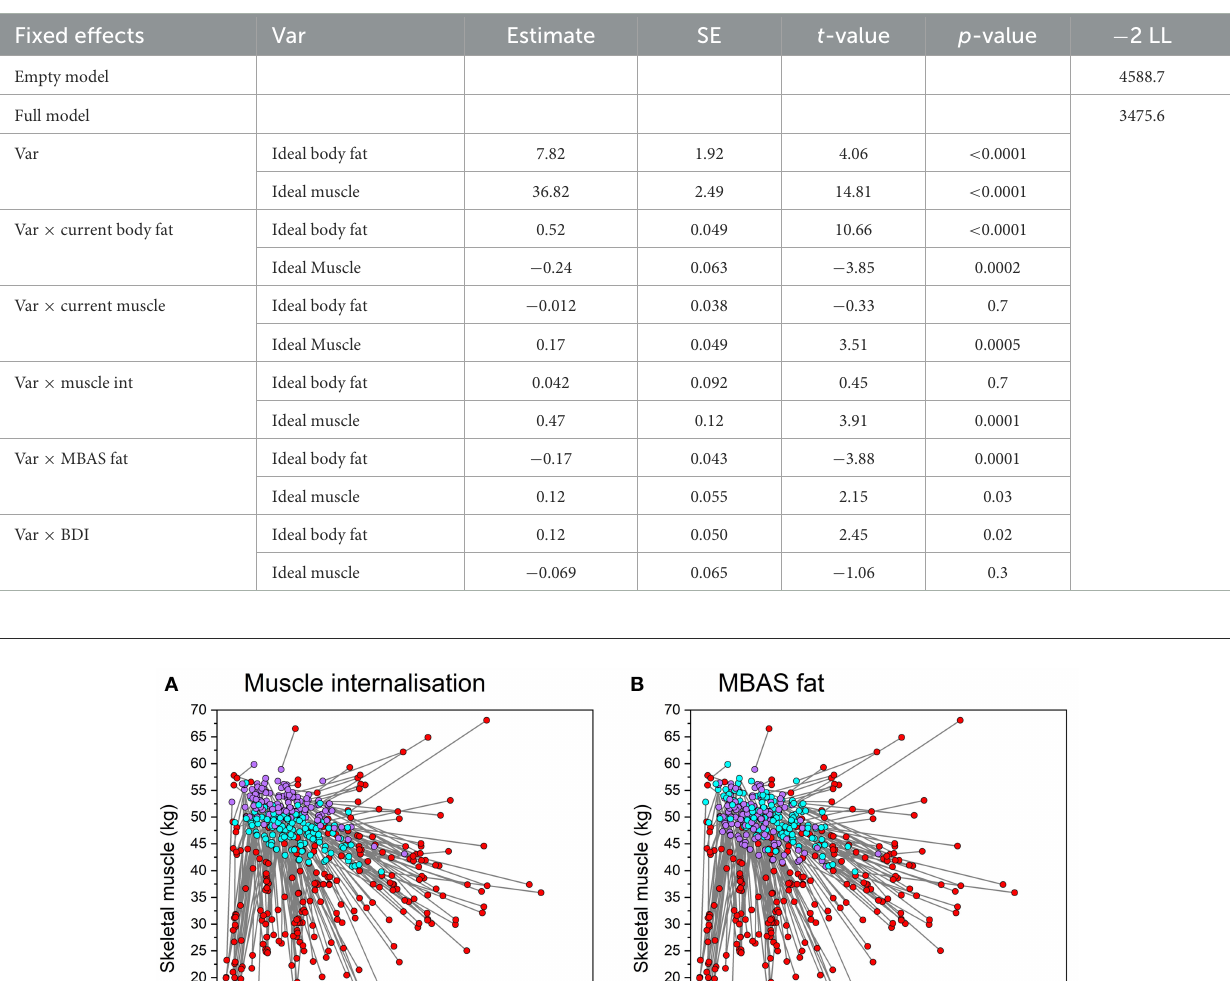
TABLE 4 Outcome from the final multivariate multiple regression model.